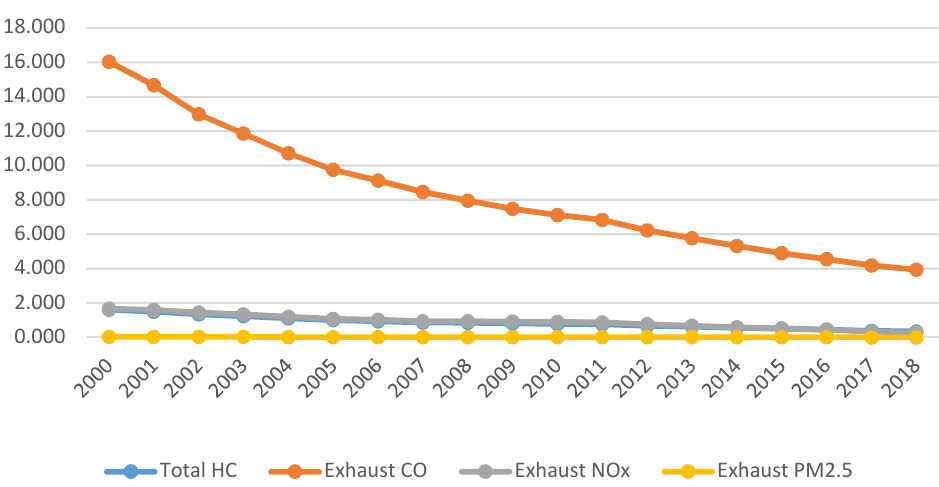
Figure 4. Estimated US average vehicle emissions rates of light-duty vehicles using gasoline [23]. Compared to the US, the Japanese automobiles’ average NO x emission measured in 2018 is lower. For light passenger vehicles that use gasoline, it was calculated that there is 0.05 g/km, and for diesel engines, it was 0.15 g/km. Japan established a law in 1992, and it was last amended in 2007 called the “NO x and PM law”. One hundred